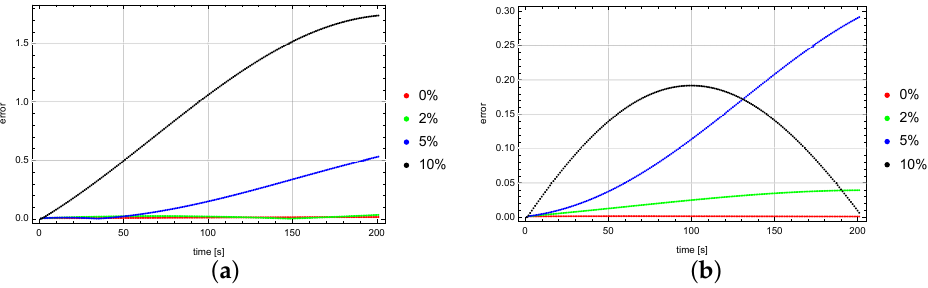
Figure 4. Errors in measurement points K 4 ( a ) and K 6 ( b ) in the case of a 100 × 100 × 200 mesh size.